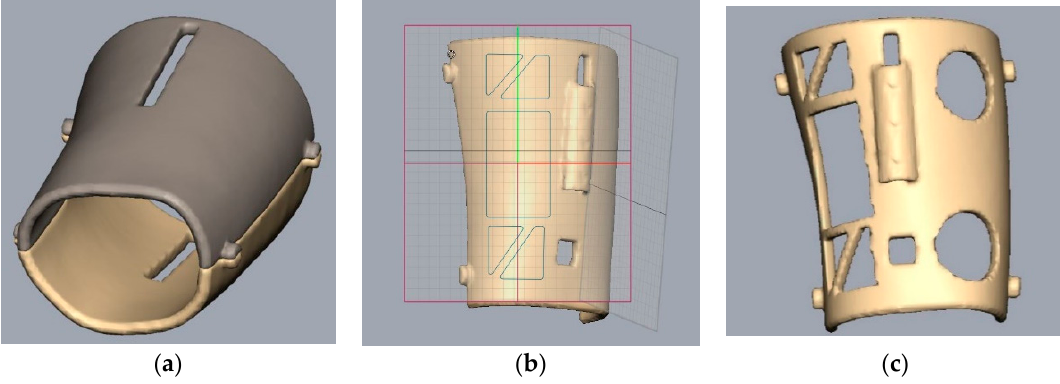
Figure 5. Different steps during the modeling of the splint: division of the splint ( a ), design of different sensor holes ( b ), and final top side splint ( c ).